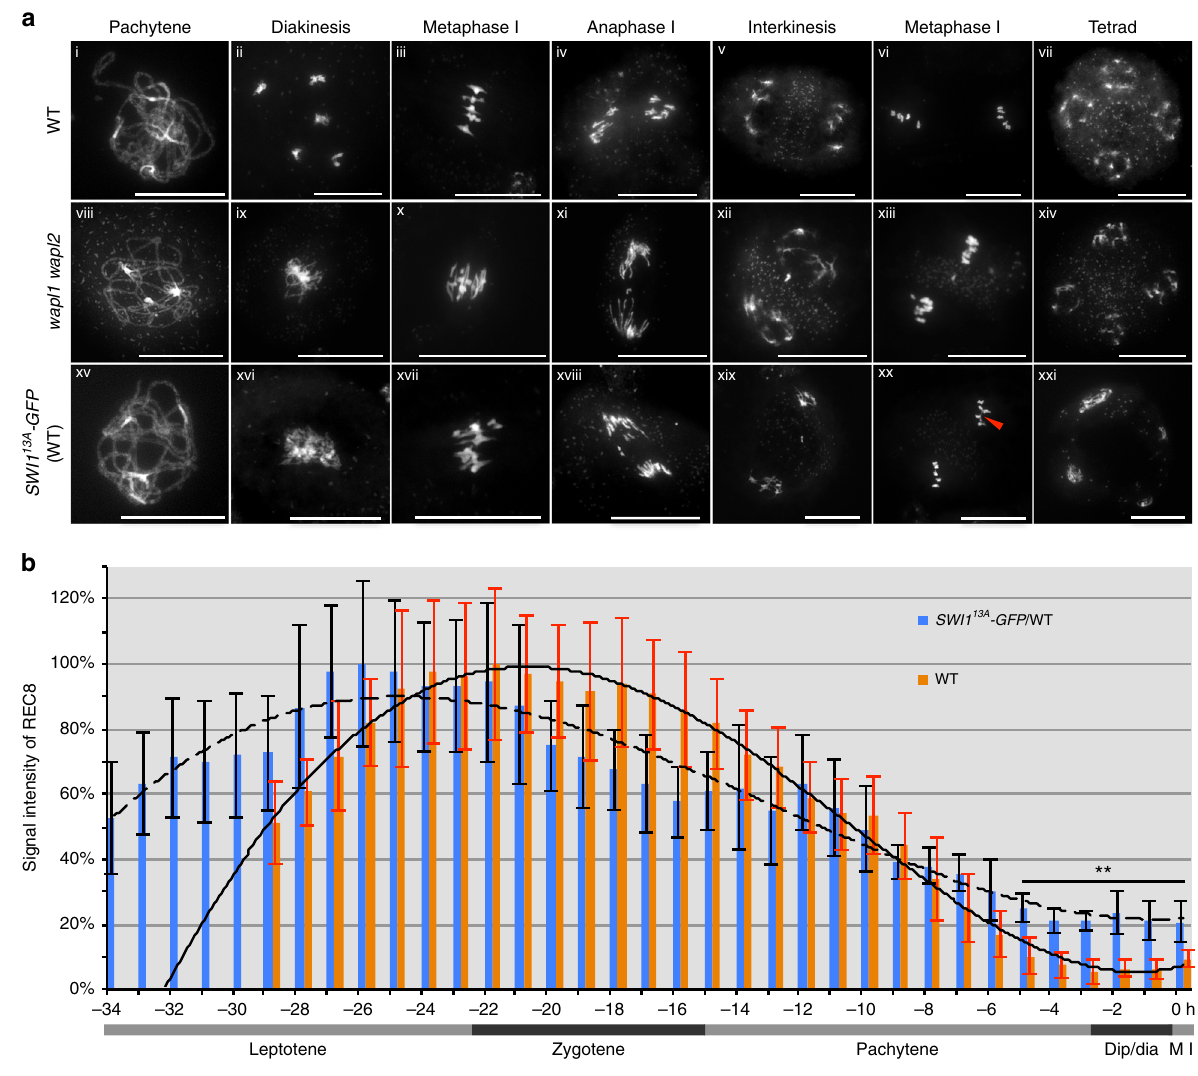
Fig. 8 De-phosphomimic SWI1 13A -GFP interferes with the cohesin removal. a Chromosome spreads of male meiocytes of the wildtype (WT), wapl1 wapl2 mutants, and SWI1 13A -GFP in wild-type plants ( SWI1 13A -GFP /WT). Bar: 20 μ m. Red arrowhead in xx highlights intertwined chromosomes. b Quanti fi cation of cohesin during meiosis I in male meiocytes of the wildtype (WT) and SWI1 13A -GFP /WT based on the analysis of a REC8-GFP reporter. The graph represents the relative intensity of the REC8-GFP signal; error bar represents standard deviation of at least 10 meiocytes analyzed. Asterisks represent signi fi cant difference (Student ’ s t -test, P < 0.01). Dip/dia diplotene/diakinesis, M I metaphase I. A solid polynomial trendline is shown for the wildtype and a dashed line for SWI1 13A -GFP /WT (correlation coef fi cient R 2 = 0.993 for the wildtype and 0.942 for SWI1 13A -GFP /WT). The source data of this graph are provided in the Source Data fi